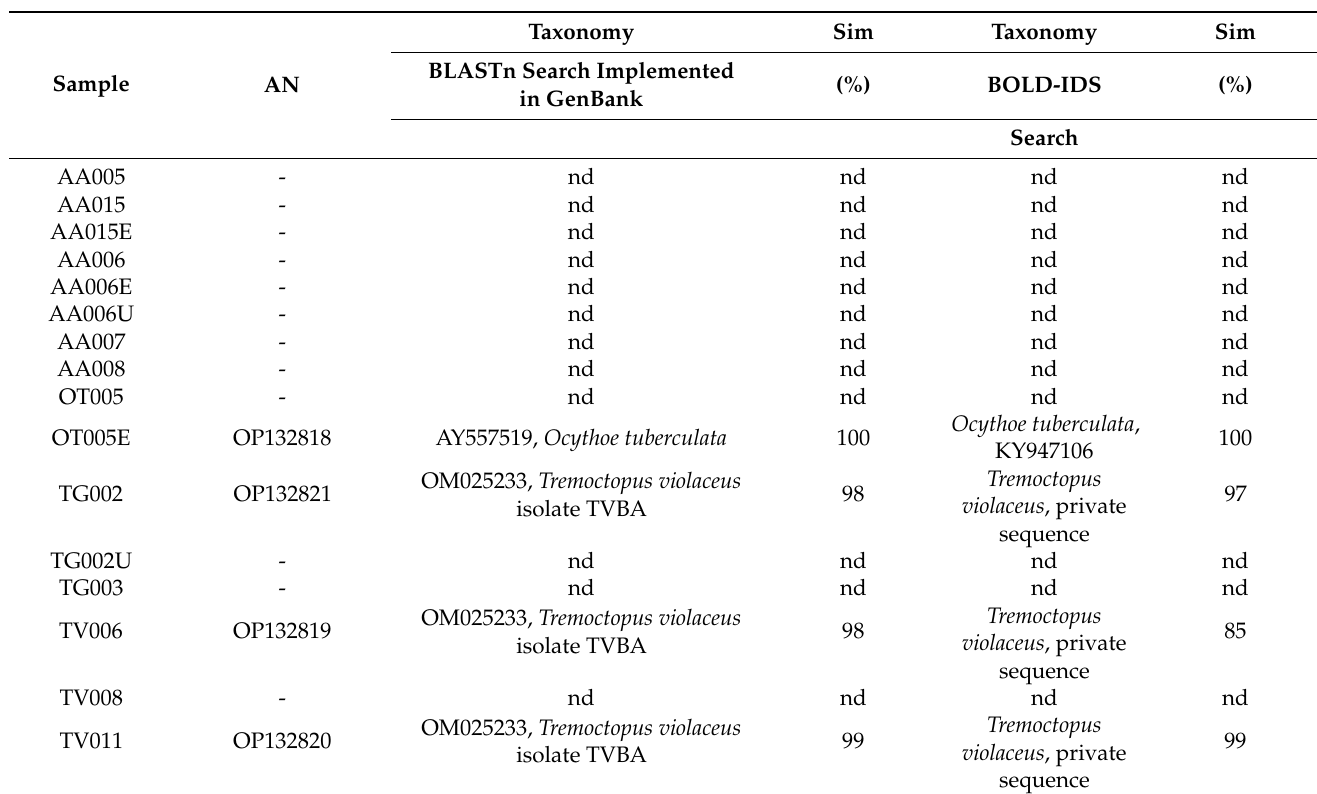
Table 1. Sample IDs, accession number and species identification assessed using the primer set Fish F2/Fish R2.